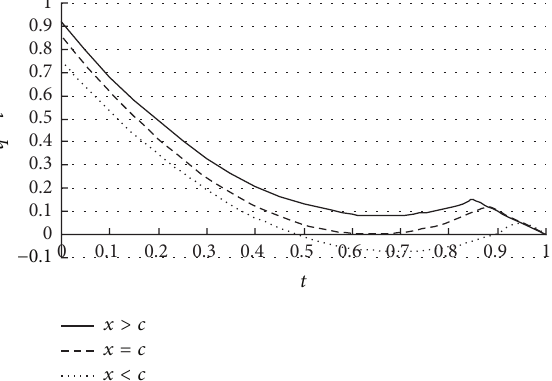
Figure 4: (𝜕𝐸 𝑘𝑖 /𝜕𝑡 𝑘𝑖 ) varies with 𝑡 𝑘𝑖 and 𝑥 = 2√𝑟 𝑘 𝑚 𝑘 − 2𝑓 𝑘 .